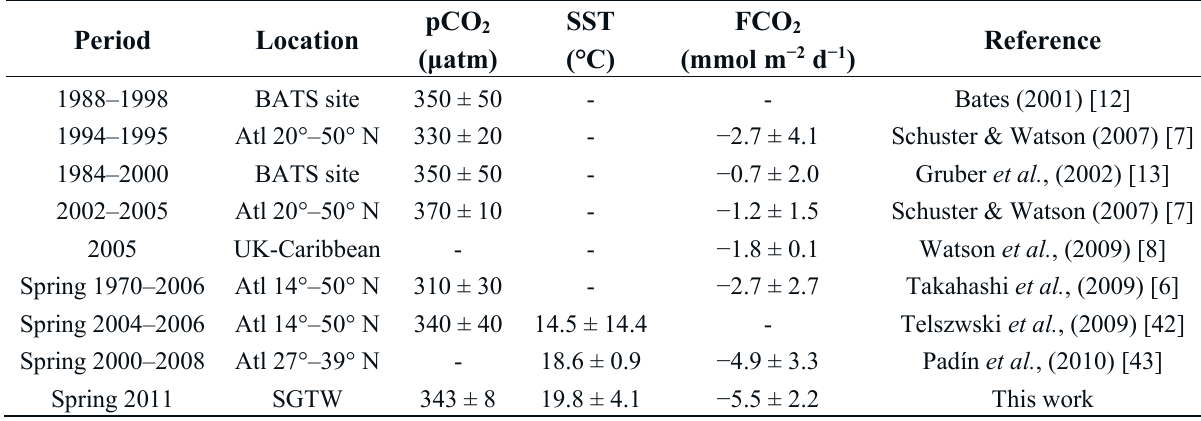
Table 2. Comparison of pCO 2 , sea surface temperature (SST) and CO 2 fluxes (FCO 2 ) between this work and other studies located in the North Atlantic subtropical